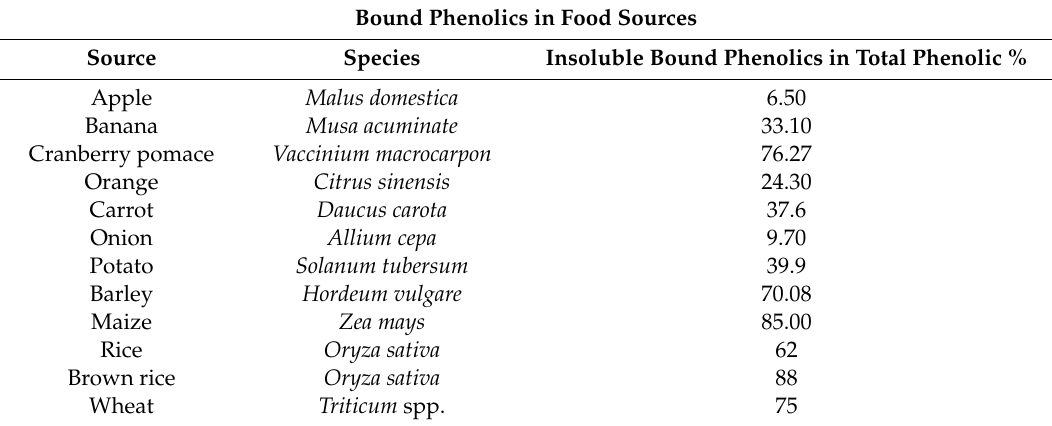
Table 4. Insoluble bound phenolic (data from